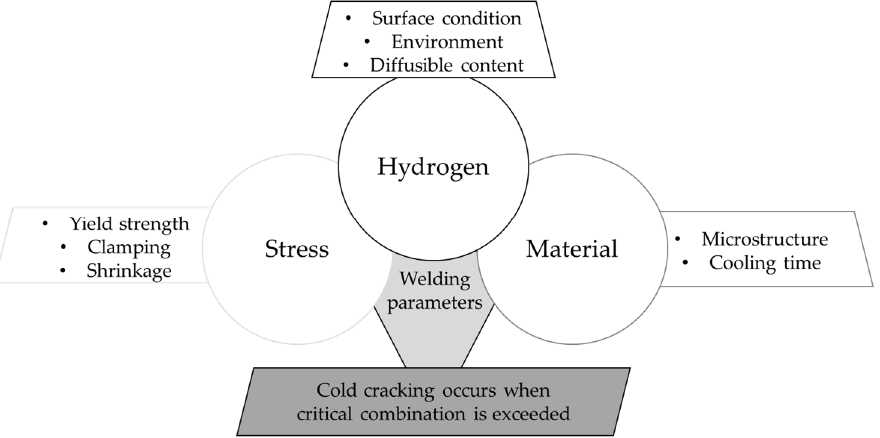
Figure 1. Main factors influencing cold cracking according to EN ISO 17462 [6].